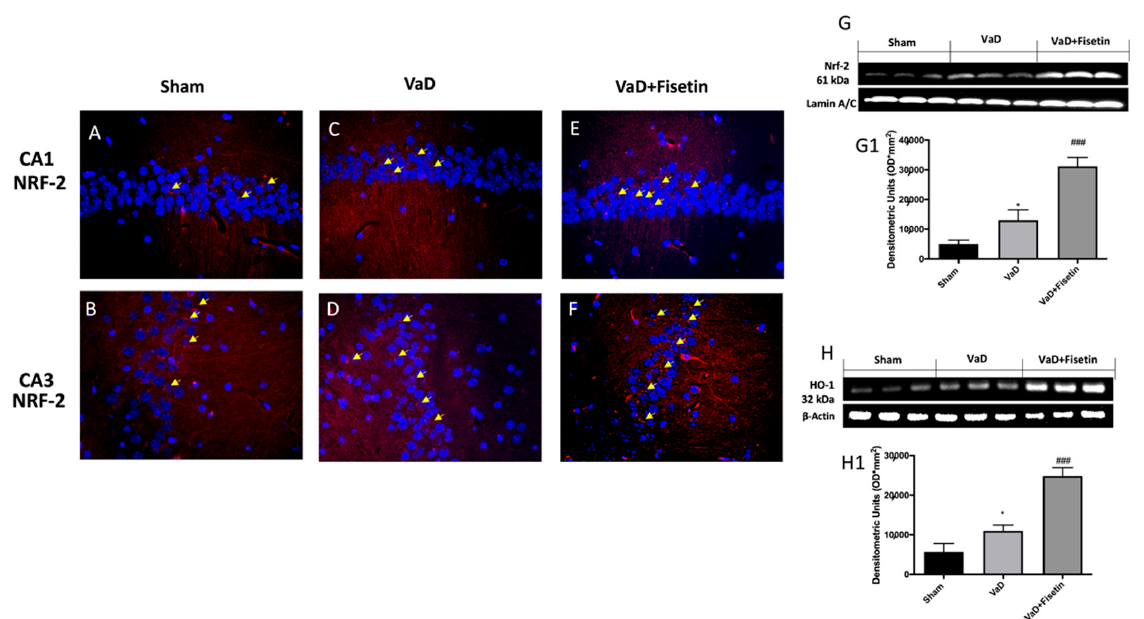
Figure 9. Fisetin administration on NRF2 pathway after VaD induction. Immunofluorescence for NRF-2 (red) in CA1 and CA3 regions, respectively, in sham animals ( A , B ), VaD animals ( C , D ), and VaD-subjected animals treated with fisetin ( E , F ). Representative Western blots on hippocampus tissues showed the effects of Fisetin on: ( G ) NRF-2, ( H ) HO-1 after VaD induction. Shown is a representative blot of lysates from 6 animals/group, together with a densitometric analysis for all animals. The results in ( G1 , H1 ) are expressed as means ± SEM of 6 animals for each group. * p < 0.05 vs. sham; ### p < 0.001 vs. VaD.